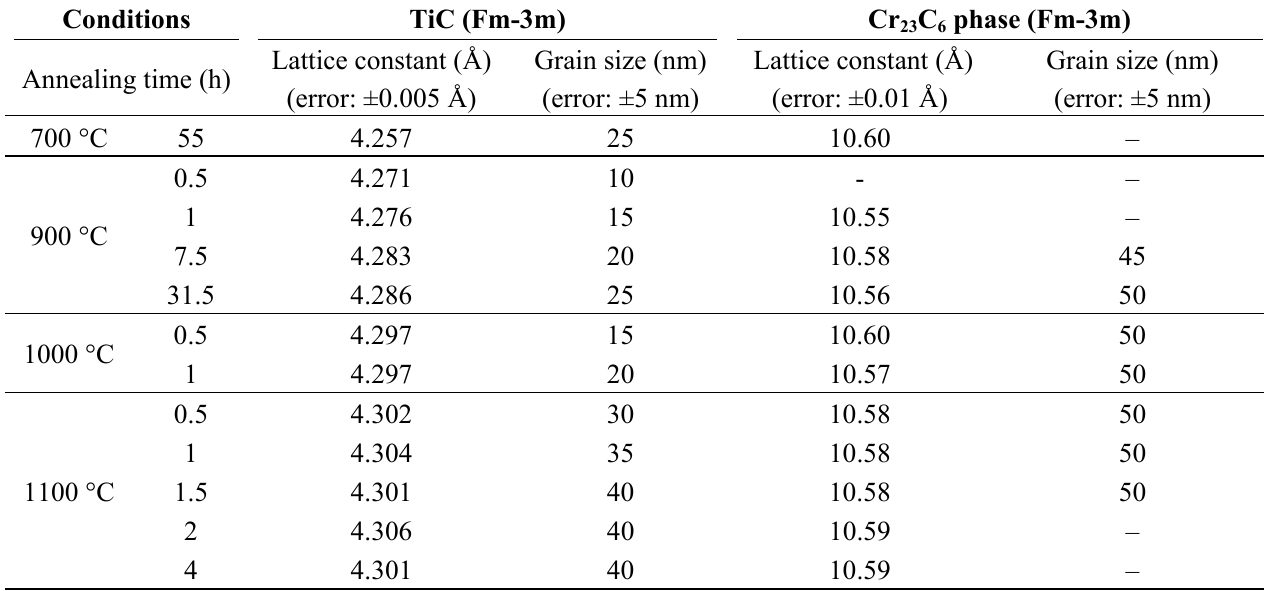
Table 2 Lattice constants and grain size for (Ti XRD measurements.